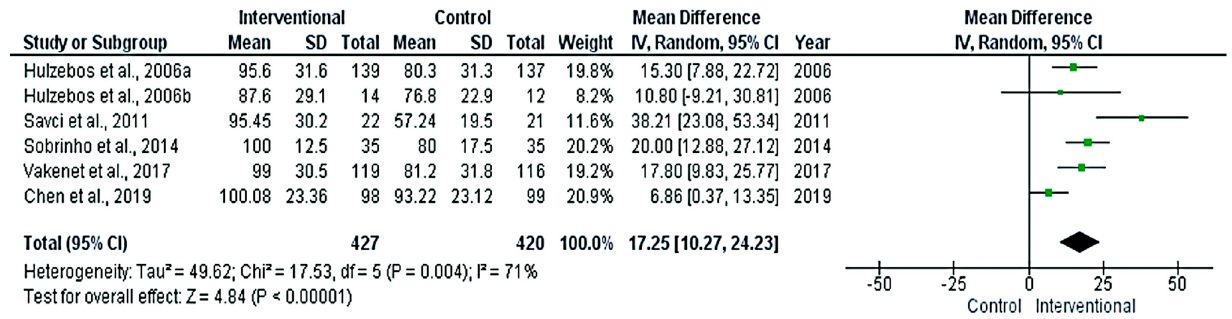
Figure 8. Forest plot evaluating Pi-max in the included studies.